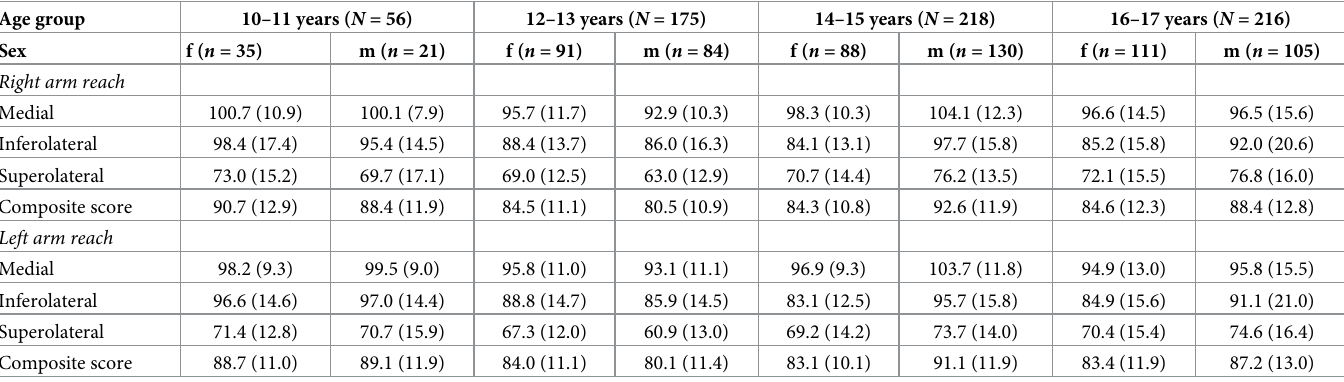
Table 2. Upper Quarter Y Balance test performance (% arm length) by age group and